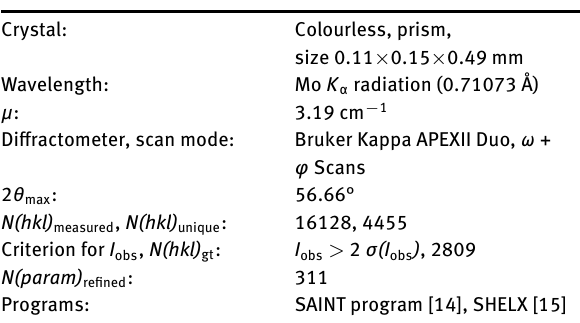
Table 1: Data collection and handling.